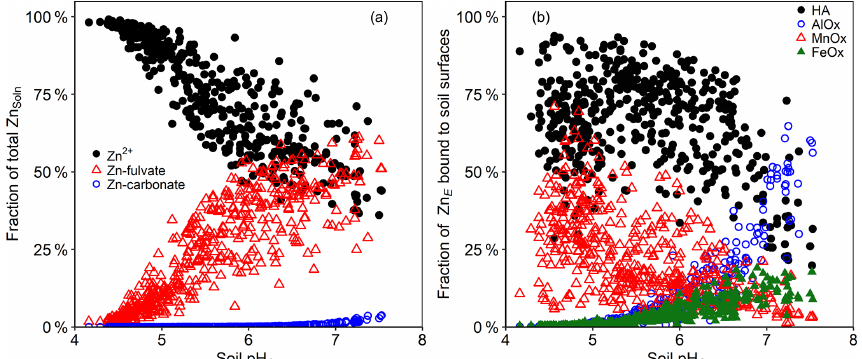
Figure 7. (a) Zn speciation in the solution phase of Ethiopian soil suspensions, as predicted by WHAM7 (free divalent ions – black cir- cles; FA complexes – red triangles; carbonate complexes – blue circles). (b) Zn fractionation in the solid phase, as predicted by WHAM7 (HA complexes – black circles; Al oxide bound – blue circles; Mn oxide bound – red triangles; Fe oxide bound – green